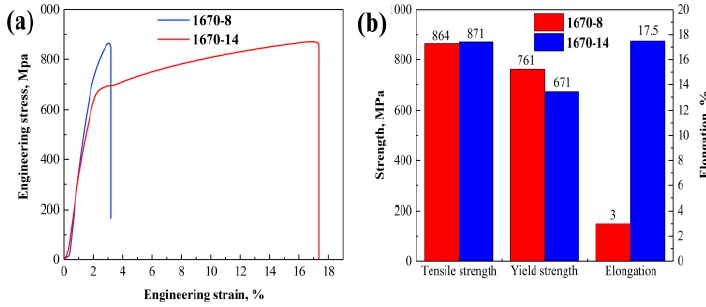
Figure 16. ( a ) stress–strain curve and ( b ) mechanical properties of the different welded joints.